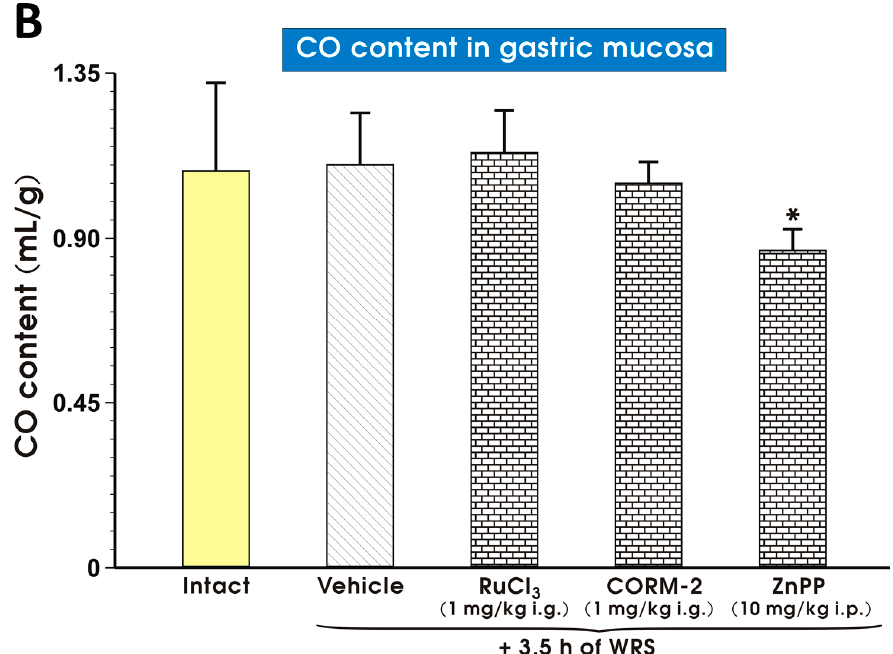
Figure 7. The gastric mucosal content of carbon monoxide (CO) and carboxyhemoglobin (COHb) concentration in rats treated i.g. with vehicle (saline; yellow pattern) and CORM-2 (1 mg/kg; line pattern) ( A ); and the gastric mucosal CO content in intact rats (yellow pattern) and in rats pretreated with vehicle (saline; i.g.; line pattern), RuCl 3 (1 mg/kg i.g.; brick pattern), CO releasing molecule 2 (CORM-2 ,1 mg/kg i.g.; brick pattern) and zinc protoporphyrin IX (ZnPP, 10 mg/kg i.p.; brick pattern) 30 min before the exposure to 3.5 h of water immersion and restraint stress (WRS) ( B ). Results are mean ± S.D. of 4–5 animals for each experimental group. Asterisk indicates significant change ( p < 0.05) as compared with vehicle-treated groups.